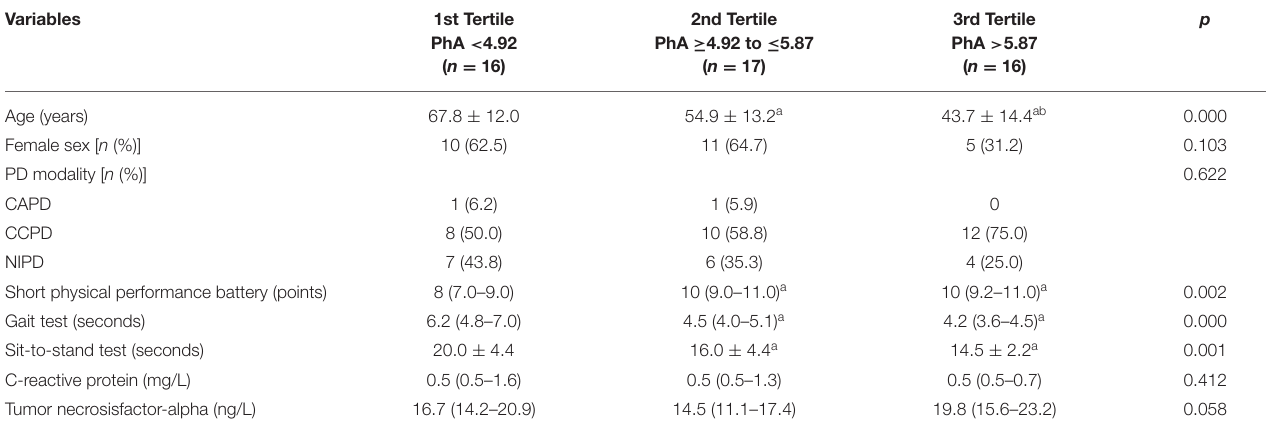
TABLE 3 | Comparison of different parameters among phase angle tertiles in patients on peritoneal dialysis ( n = 49).